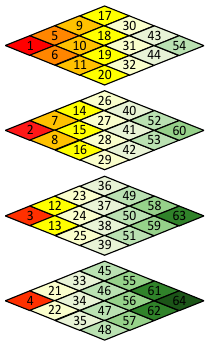
Figure 7. 3D Zigzag scan order.